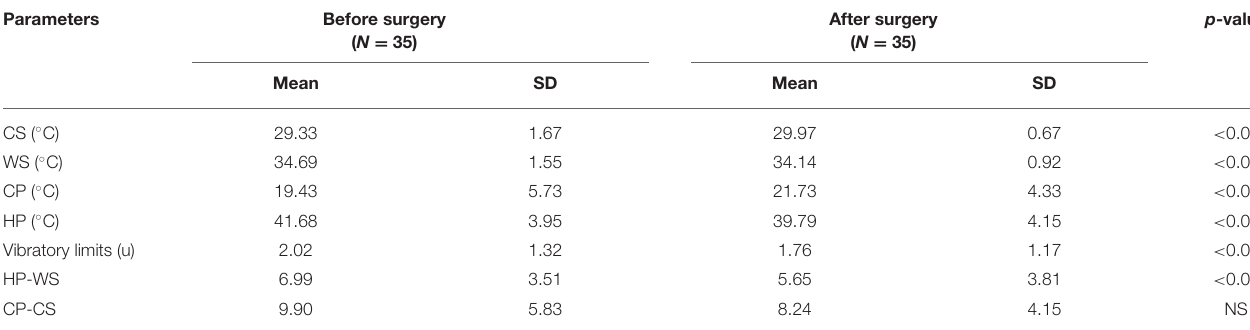
TABLE 3A | Mean values of QST before and after surgery in CTS patients. Parameters